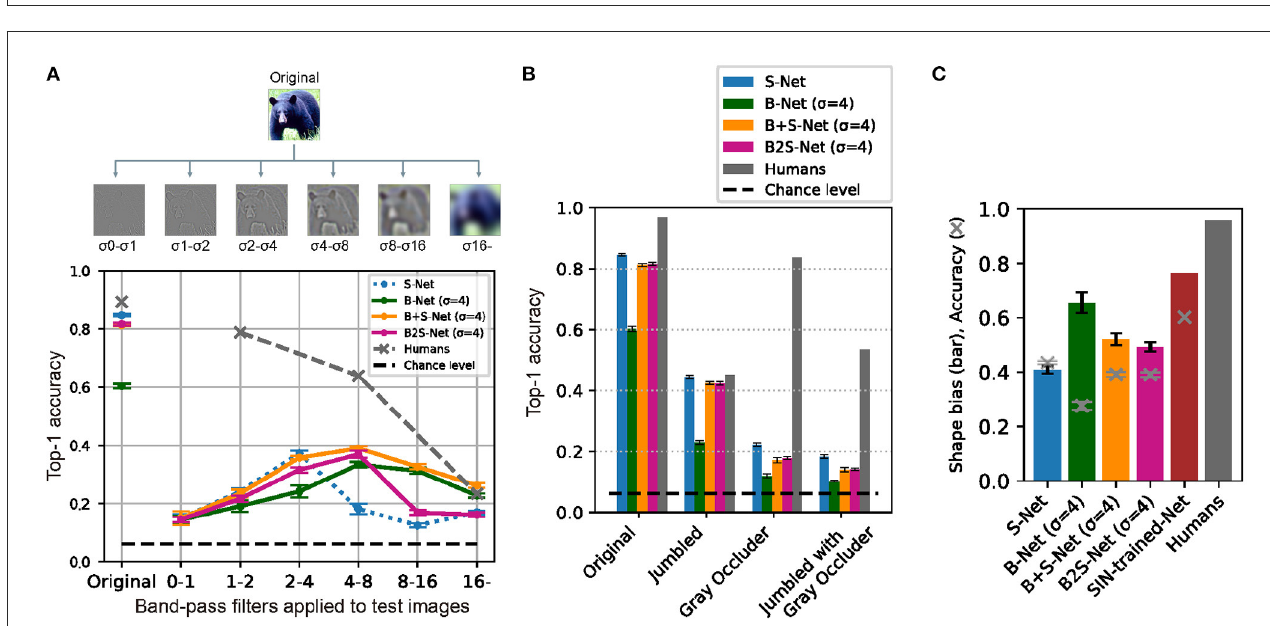
FIGURE2 Blur training does not bridge the gaps between CNN and humans in recognition of (A) band-pass filtered object images, (B) jumbled/occluded images (Keshvari et al., 2021), and (C) shape-texture-cue-conflict images (Geirhos et al., 2019). The ordinate is the Top-1 accuracy of object classification. The exception is (C) , where shape bias is shown by bars, and classification accuracy on Stylized ImageNet (SIN) by crosses. Human accuracy for (B, C) are from the original studies. Error bars represent 95% confidence intervals estimated from the performances of eight models trained with different random seeds.